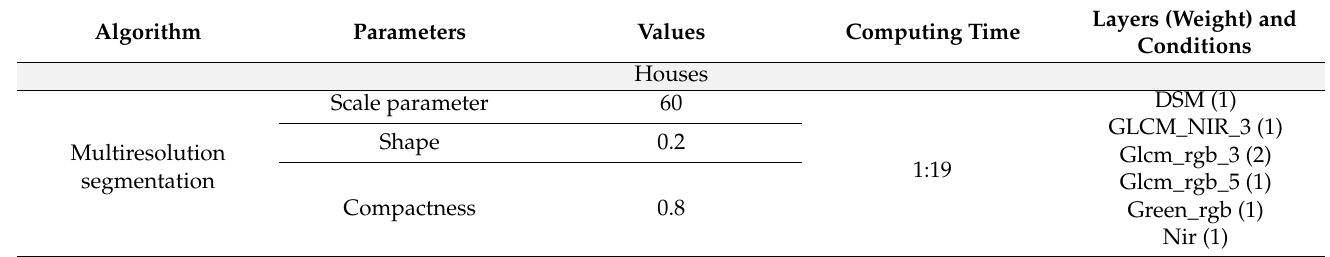
Table A2. Segmentation ruleset applied for the Land Cover OBIA classification of Tour è